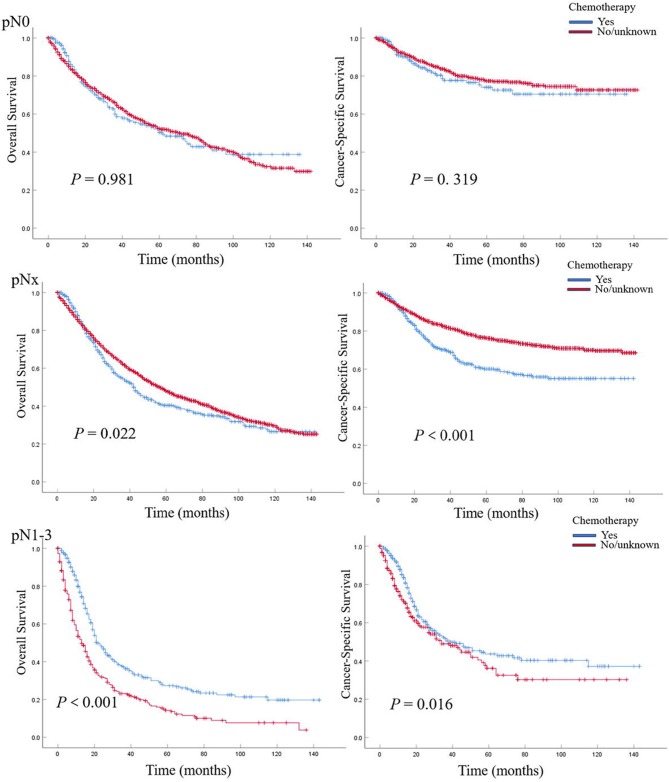
Kaplan–Meier plots depicting overall survival (OS) and cancer-specific survival (CSS) for pN0, pNx, and pN1–3 diseases, after stratification according to perioperative chemotherapy record in 7,278 patients treated with nephroureterectomy between 2004 and 2015, within the Surveillance, Epidemiology, and End Results database.